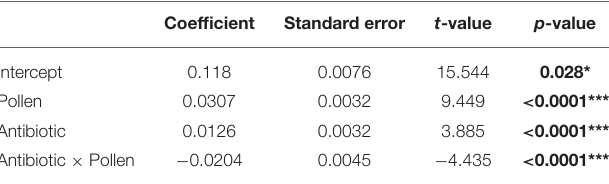
TABLE 5 | Summary output from a linear mixed effect model of weight (in grams) of adult Apis mellifera workers dependent on pollen and antibiotics, with cage and day defined as random